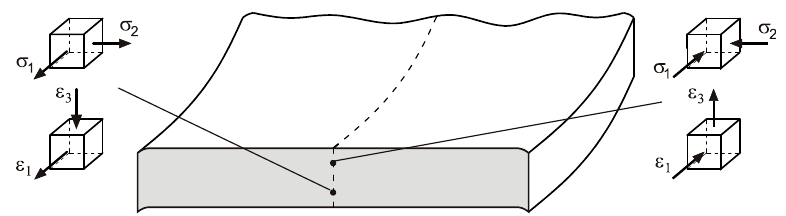
Figure 9. Stress and strain state during V-bending of a sheet strip.